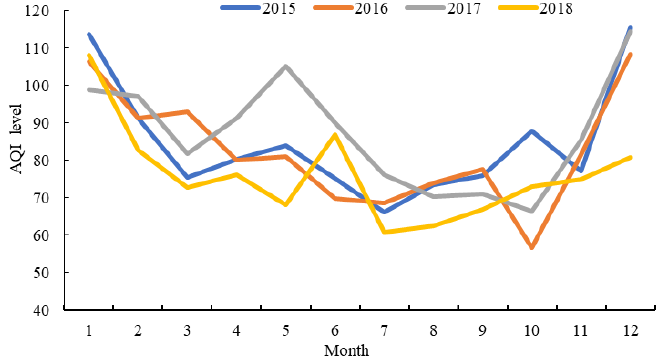
Figure 1. The monthly trend of the AQI value in the YRD from 2015 to 2018 .